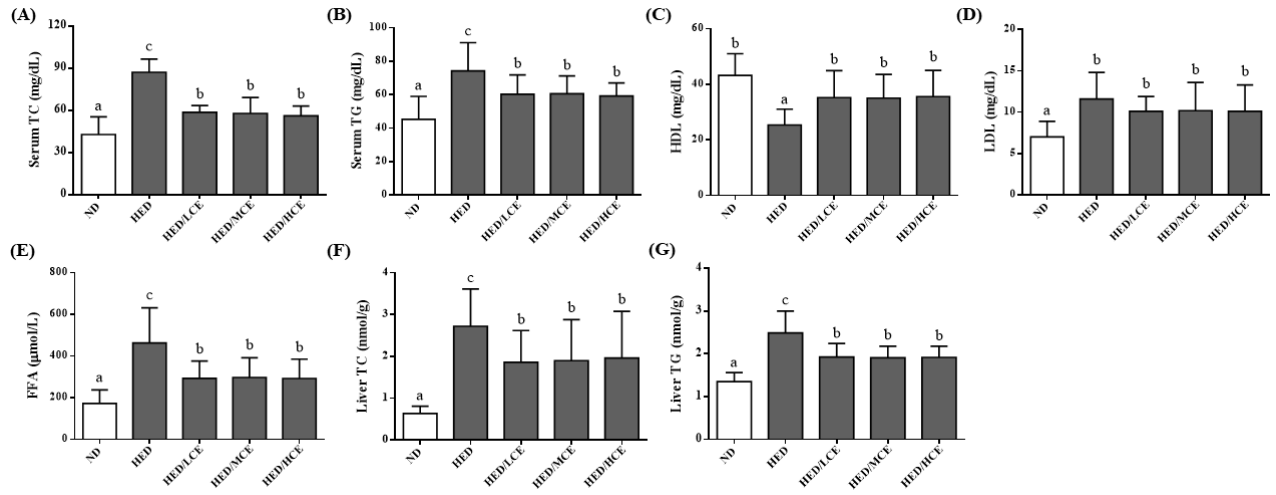
Figure 2. Effects of phlorotannin-rich extracts from A. nodosum and F. vesiculosus on serum ( A ) TC, ( B ) TG, ( C ) HDL-C, ( D ) LDL-C, ( E ) FFAs, and liver ( F) TC and ( G ) TG of rats with high-energy diet–